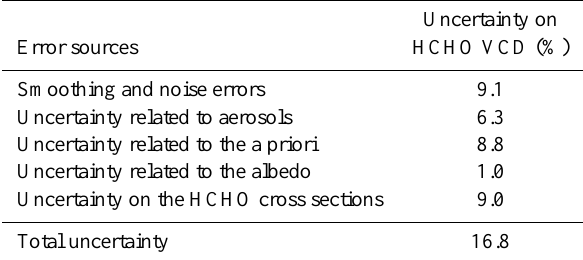
Table 3. Error budget on the retrieved HCHO vertical column den- sity (VCD) for the MAX-DOAS measurements. The total uncer- tainty is calculated by adding the different error terms in Gaussian